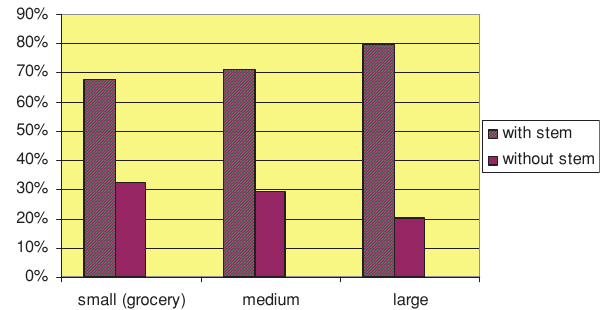
Figure 5. The rate of sour cherry fruits offered with stem and without stem in three different size categories of retail shops Source: